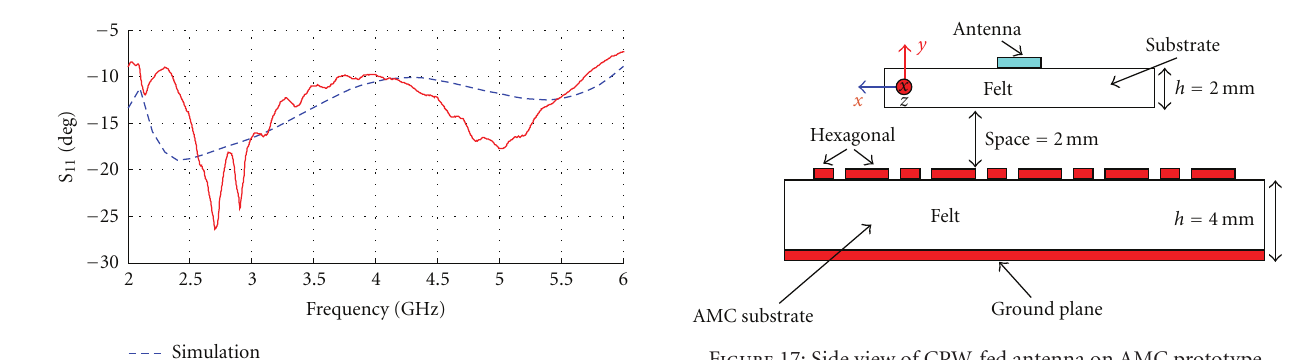
Figure 17: Side view of CPW-fed antenna on AMC prototype.